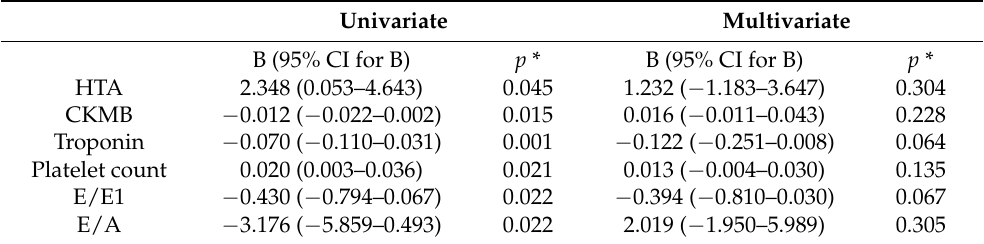
Table 7. Univariate and multivariate regression analysis demonstrating the relationship between baseline characteristics and galectin-3 concentration on day 5 in STEMI.